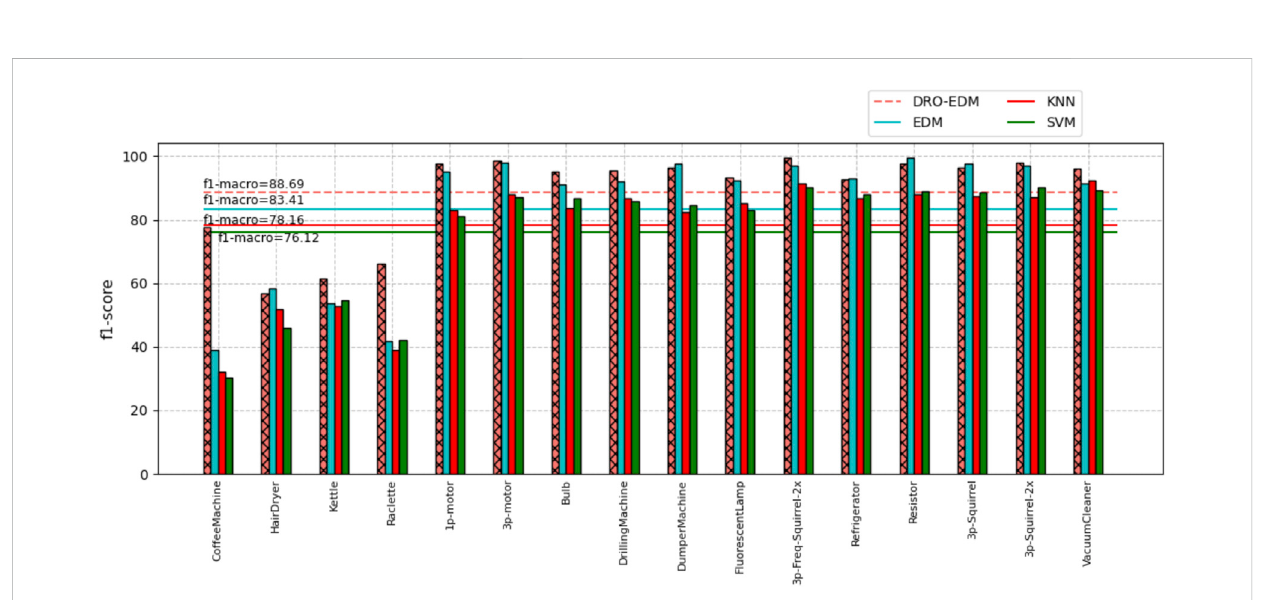
FIGURE 6 F1-score of appliance loads for the LILACD with